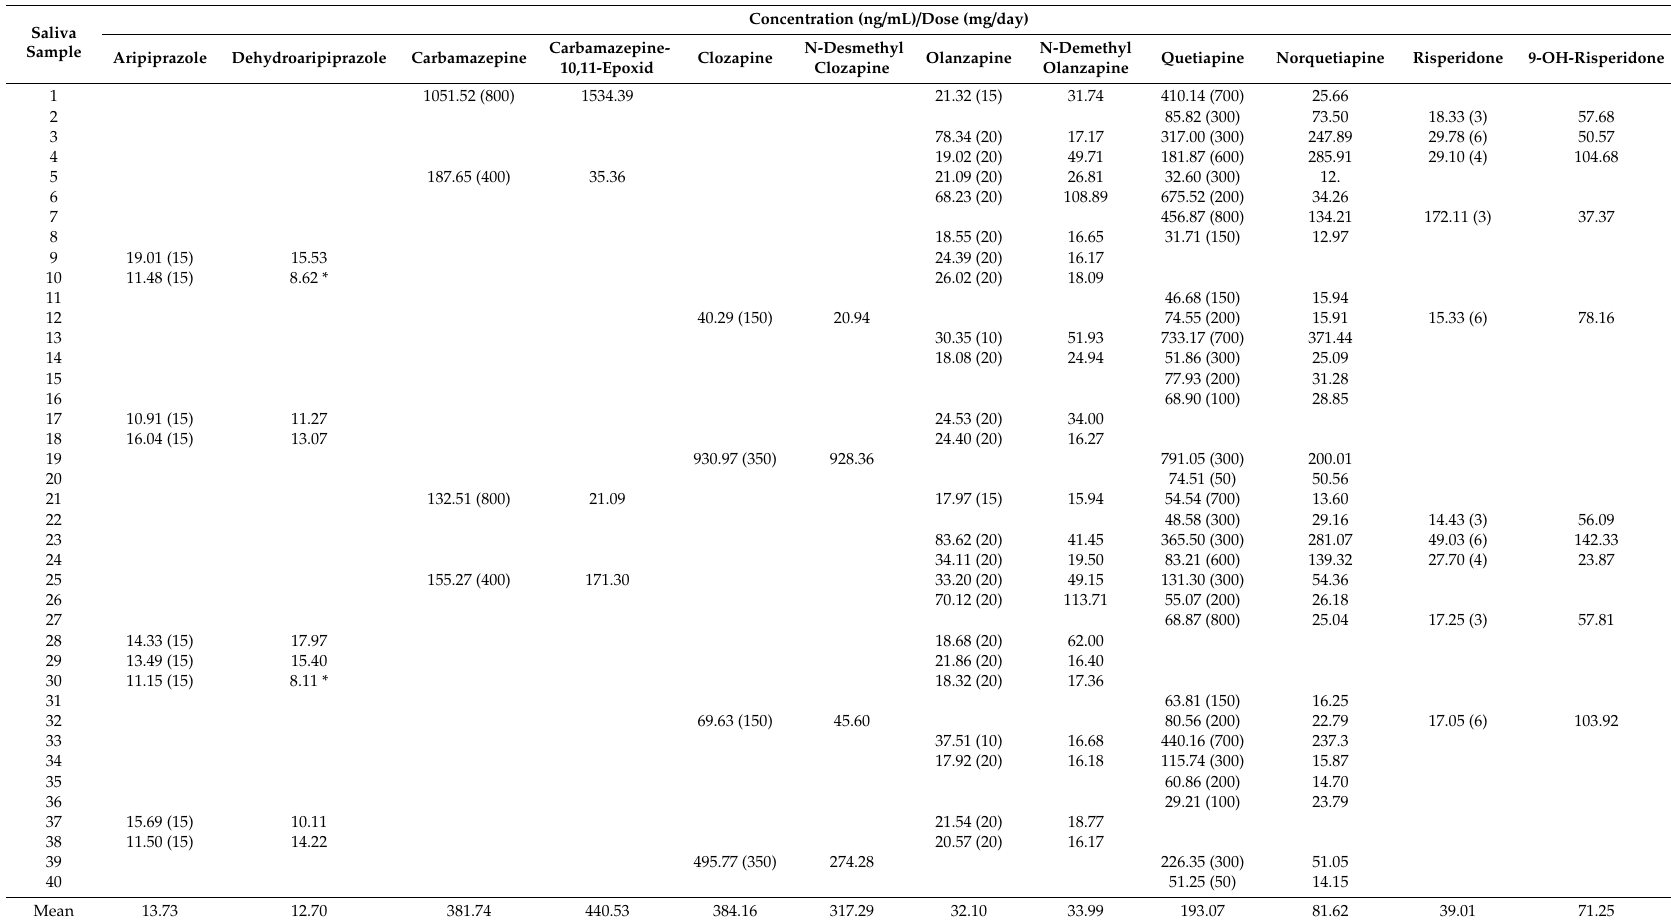
Table 4. The concentrations of neuroleptic drugs and their metabolites in saliva samples (drug doses in mg / day used by patients are given in the parentheses). Saliva